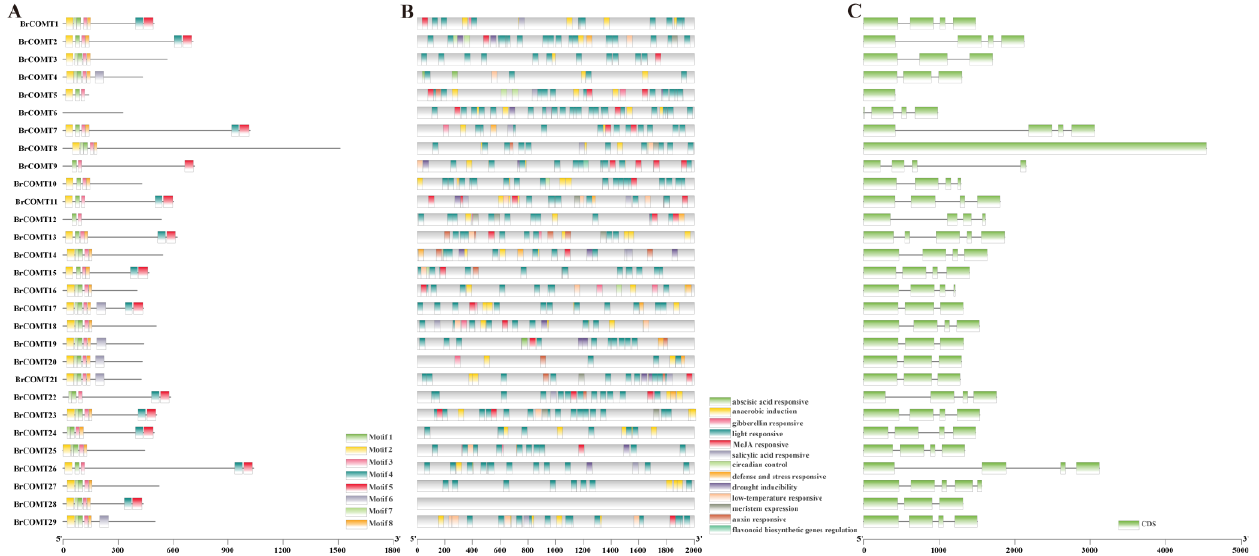
Figure 7. Conserved analysis of the 29 BrCOMT genes. ( A ) Amino acid sequence analysis. ( B ) Anal- ysis of cis-acting elements of promoters. ( C ) Exon and intron analysis.